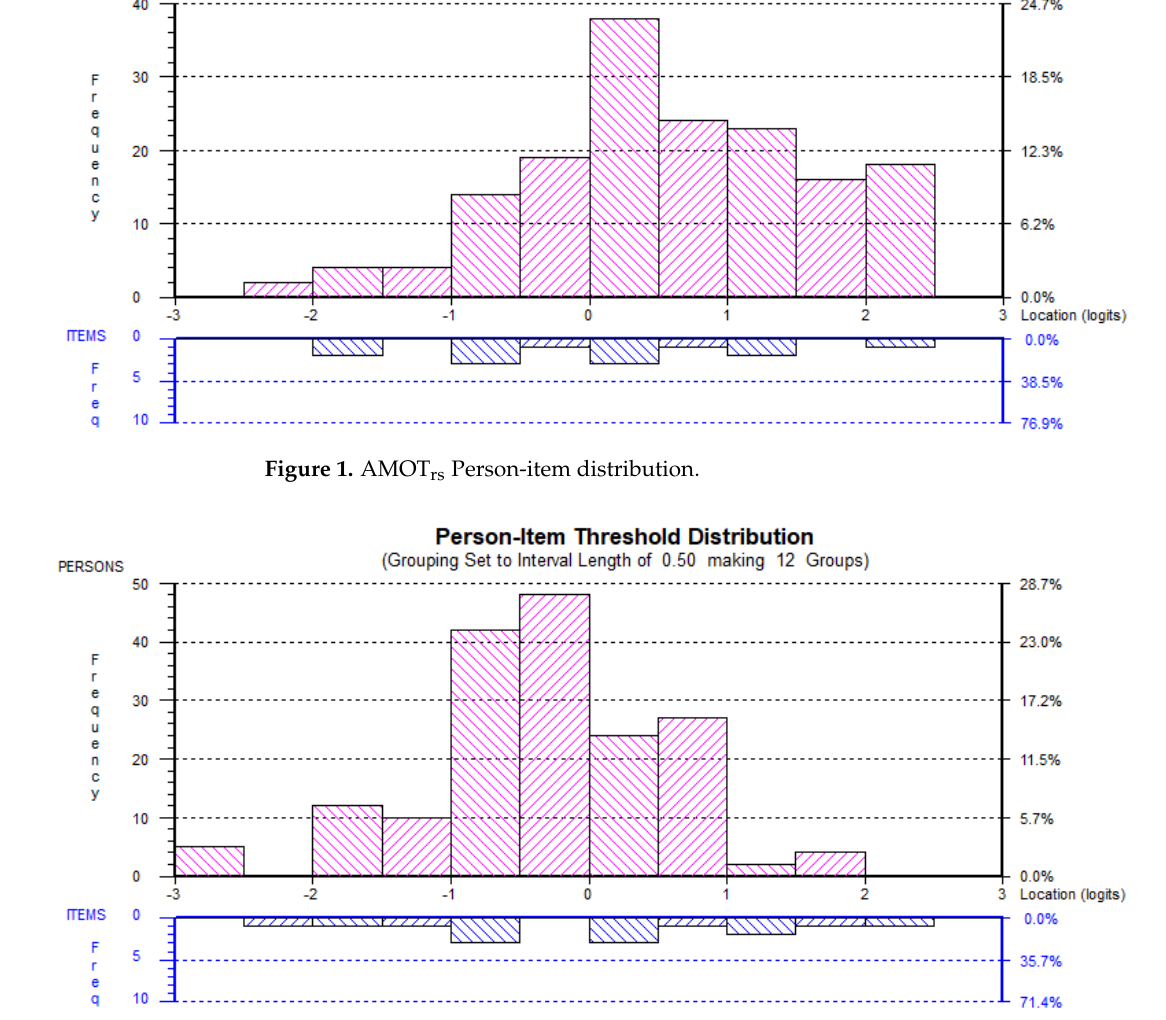
Figure 2. EMER rs Person-item distribution.